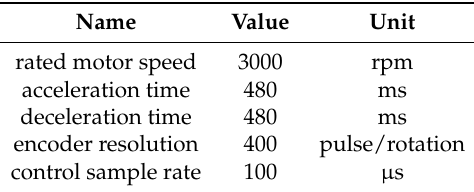
Figure 8. Experiment setup. Table 2. Experimental